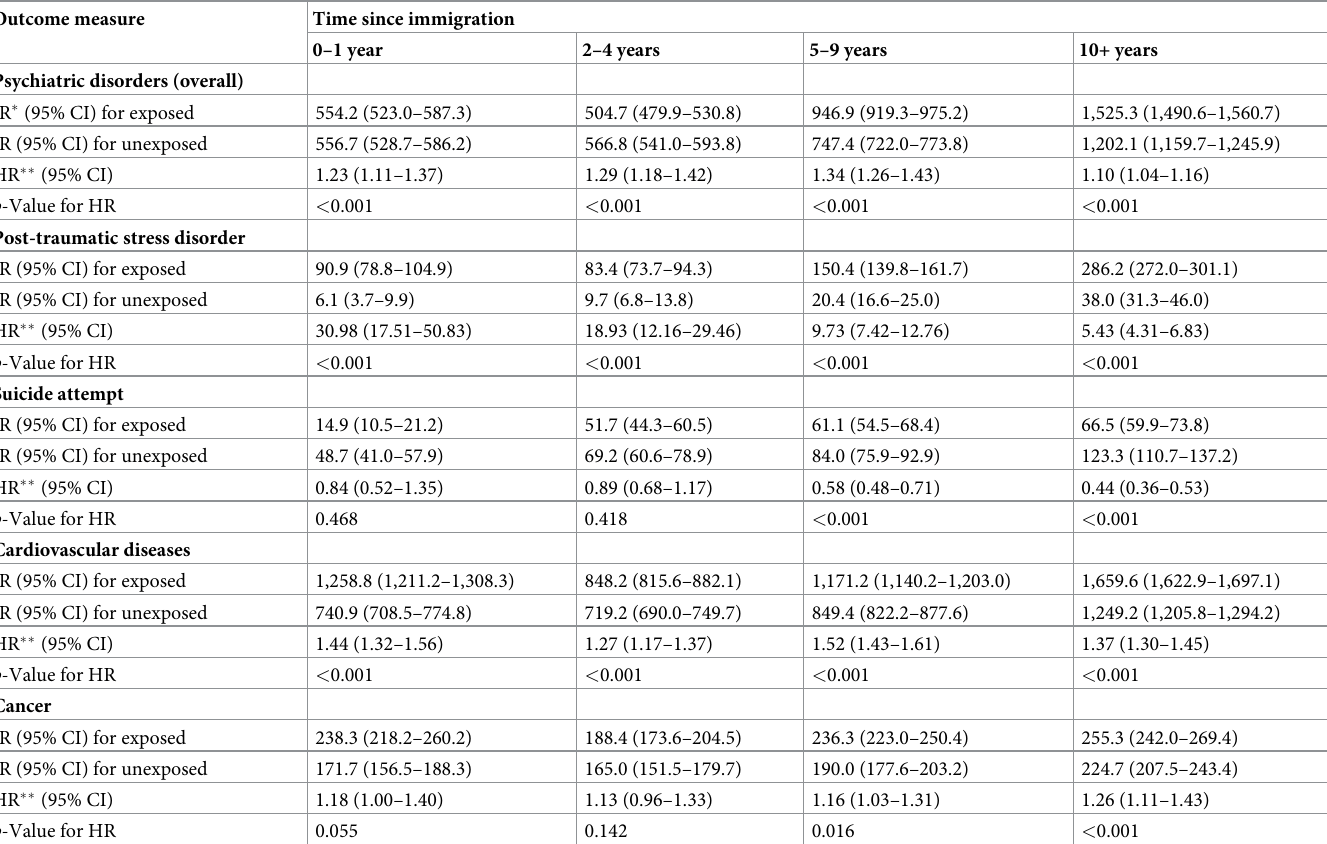
Table 5. Rates of morbidities in migrants of the Balkan wars (exposed) compared to other European migrants (unexposed), by time since immigration. Outcome